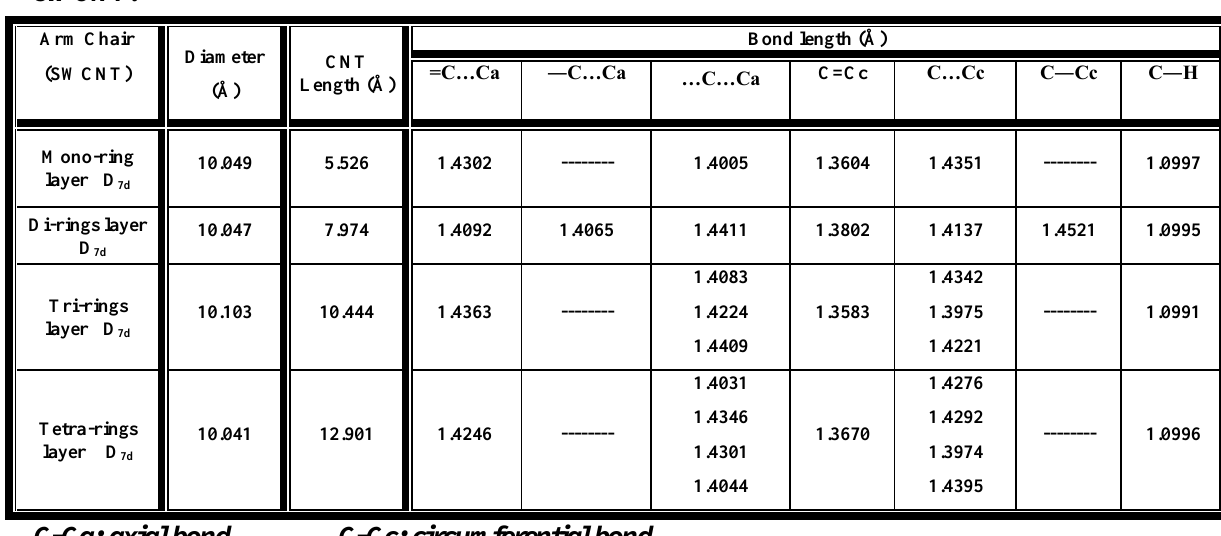
Fig.4: Repetitive sections of bonds and angles for (mono, di, tri and tetra) rings layer of (7,7) armchair SWCNT at their equilibrium geometries according to their point group (D Table1: PM3 calculated bond distances of (mono, di, tri and tetra) rings layer for (7,7) Arm Chair